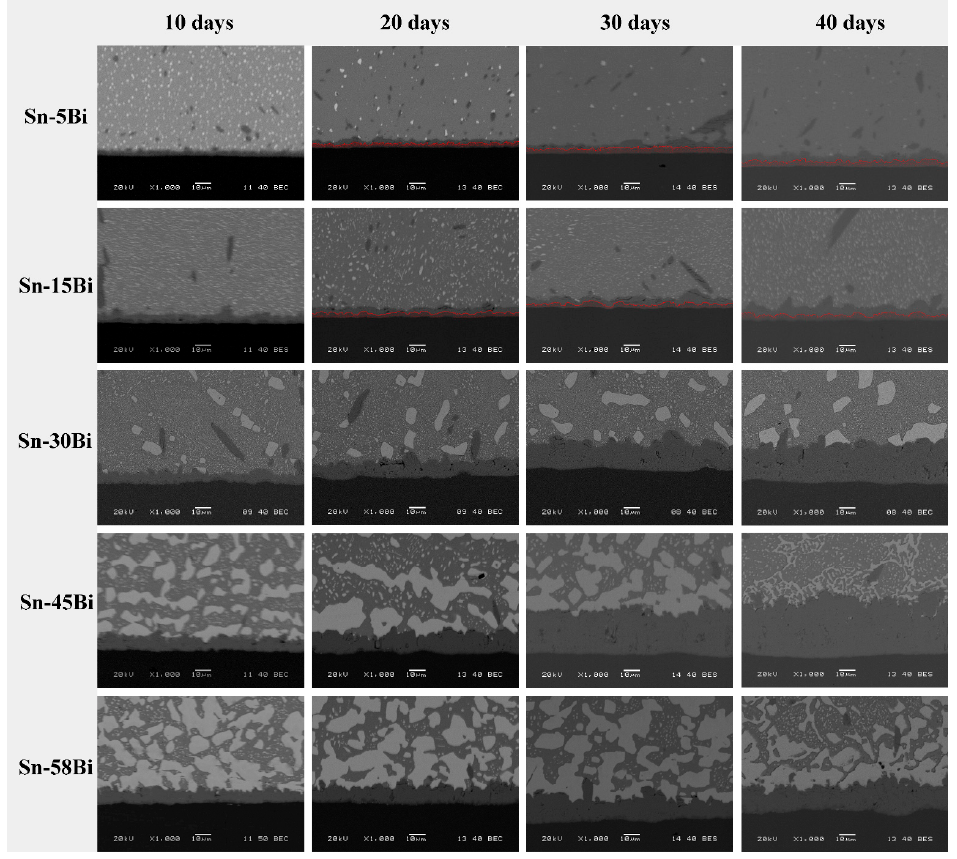
Figure 6. Interfacial evolution of Sn-Bi solder joints with different Bi content under the aging condition.